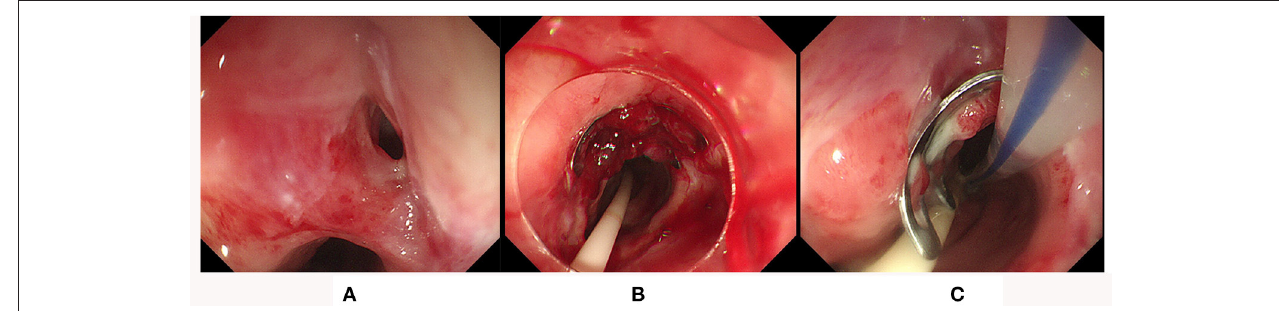
FIGURE 4 | OTSC closure of the tracheoesophageal fistula. (A,B) The fistula was successfully treated by OTSC; (C) a follow-up endoscopy at 10 days after OTSC placement found the clip was still in place and the fistula was sealed